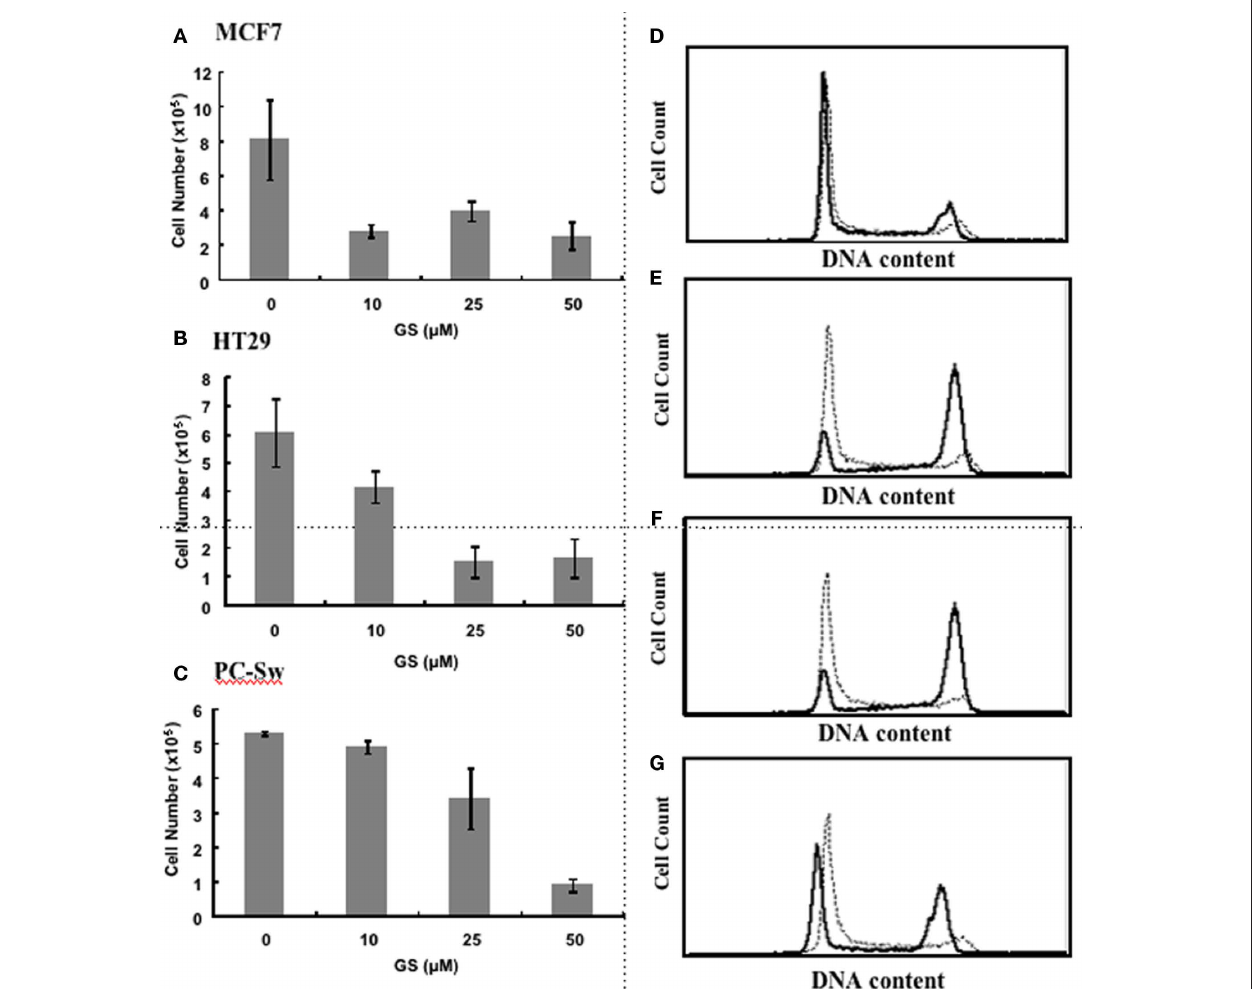
followed by 6 Gy IR. (D) untreated PC-Sw cells (solid line) vs 24 h GS-treated PC-Sw cells (dotted line). (e) 6 h post-IR (solid line) vs 6 h post-IR + 50 μM GS (dotted line) cells, (F) 12 h post-IR (solid line) vs 12 h post-IR + 50 μM GS (dotted line) cells, (g) 18 h post-IR (solid line) vs 18 h post-IR vs 18 h post-IR + 50 μM GS (dotted line)